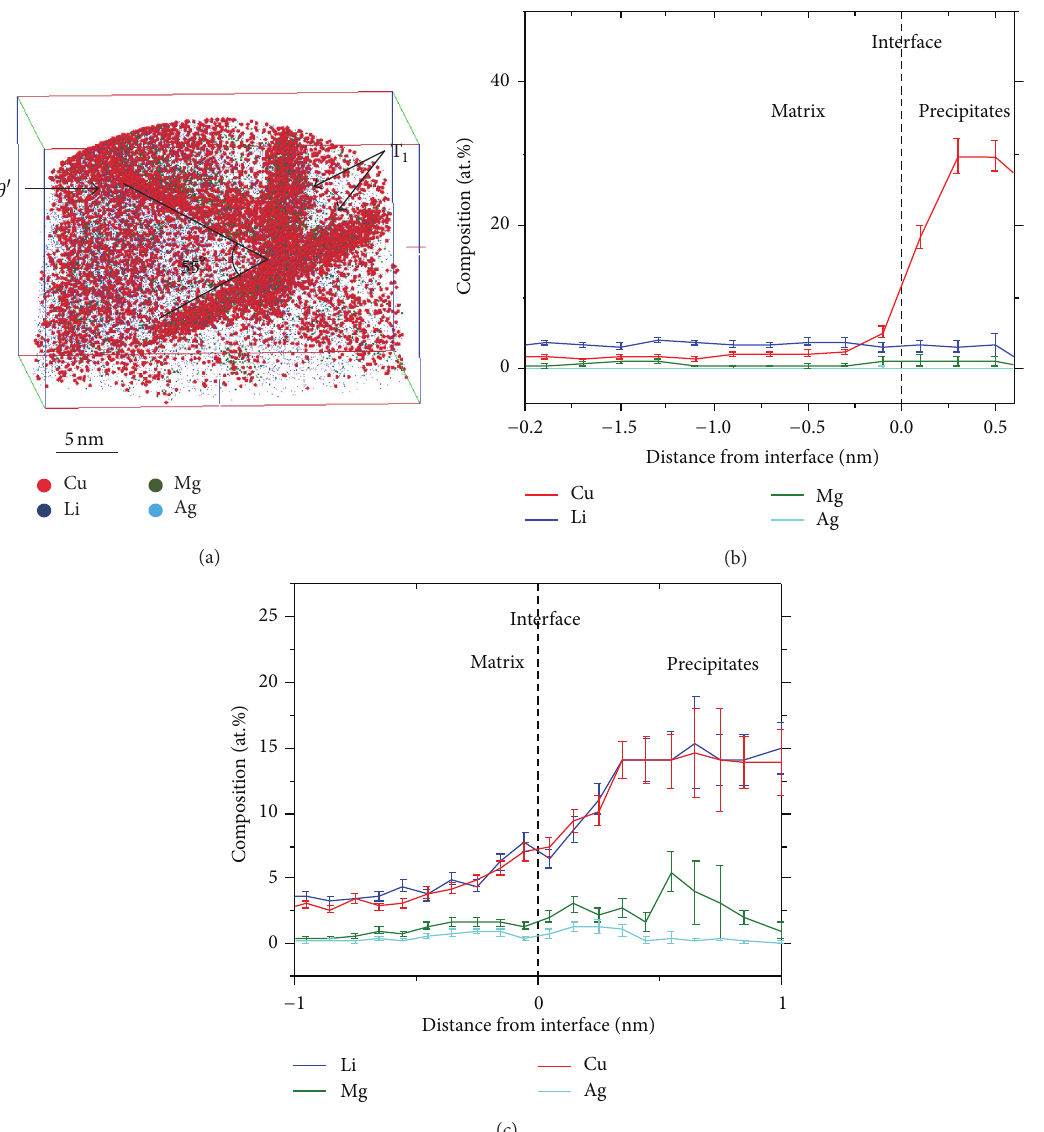
Figure 5: LAWATAP analysis with new experimental parameters 25 K and 22.5% of pulse fraction. (a) Reconstructed volume, obtained with laser assisted wide angle tomographic atom probe, shows T 1 and 𝜃 󸀠 platelets. (b) Corresponding proxigram composition profile for 𝜃 󸀠 gives an optimistic chemical composition as ( 30 ± 2 ) at.% Cu, ( 3 ± 1 ) at.% Li, and ( 1 ± 0.7 ) at.% Mg. (c) Corresponding combined proxigram composition profile for T 1 with the chemical composition of ( 14 ± 1 ) at.% Cu, ( 14 ± 2 ) at.% Li, ( 3.8 ± 1 ) at.% Mg, and ( 0.8 ± 0.4 ) at.%